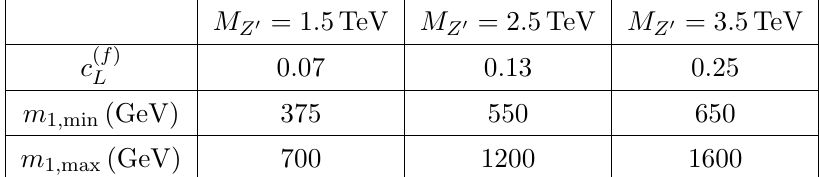
1 and choice for c 0 : 8). (cid:0)